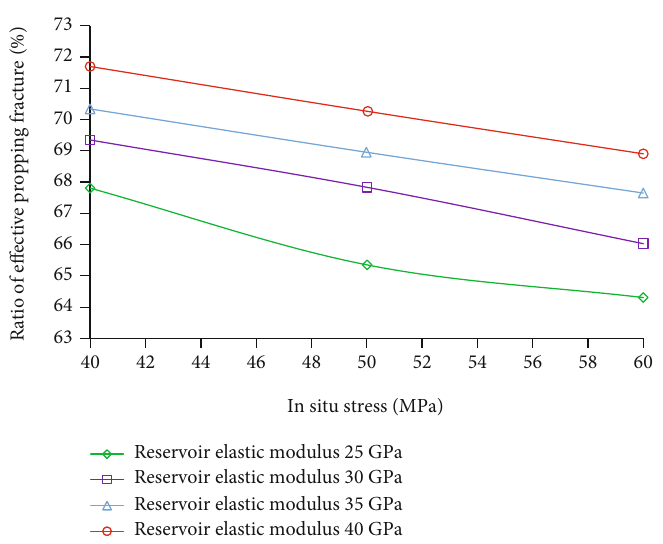
Figure 30: The in fl uence of in situ stress on e ff ective supporting cracks.